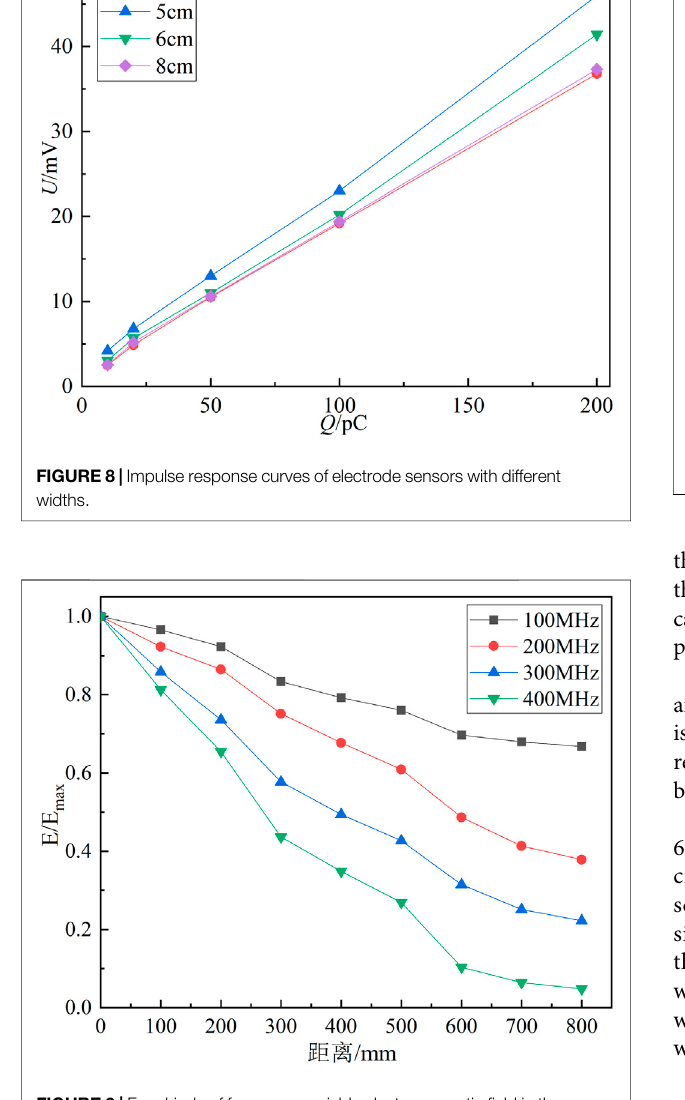
FIGURE 9 | Four kinds of frequency variable electromagnetic fi eld in the joint electric fi eld component with distance transmission attenuation change